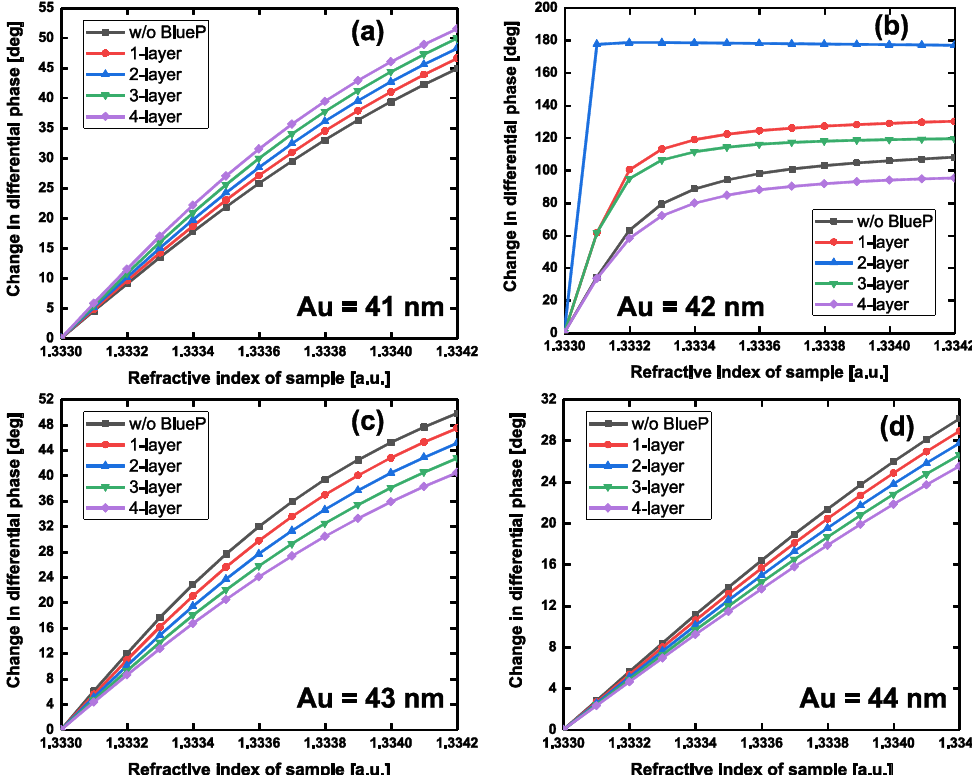
Figure 6. Change in differential phase with respect to the variation in local refractive index of the sensing interface by modulating the numbers of the BlueP interlayer and the thickness of Au film: ( a ) 41 nm, ( b ) 42 nm, ( c ) 43 nm, and ( d ) 44 nm, respectively.